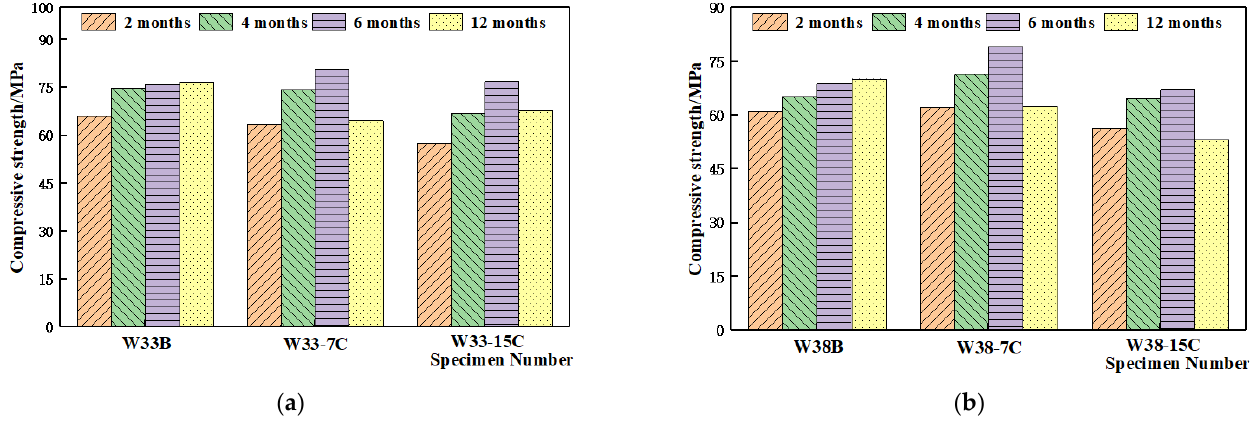
Figure 2. Compressive strength in different test conditions: ( a ) W/C ratio of 0.33; ( b ) W/C ratio of 0.38.